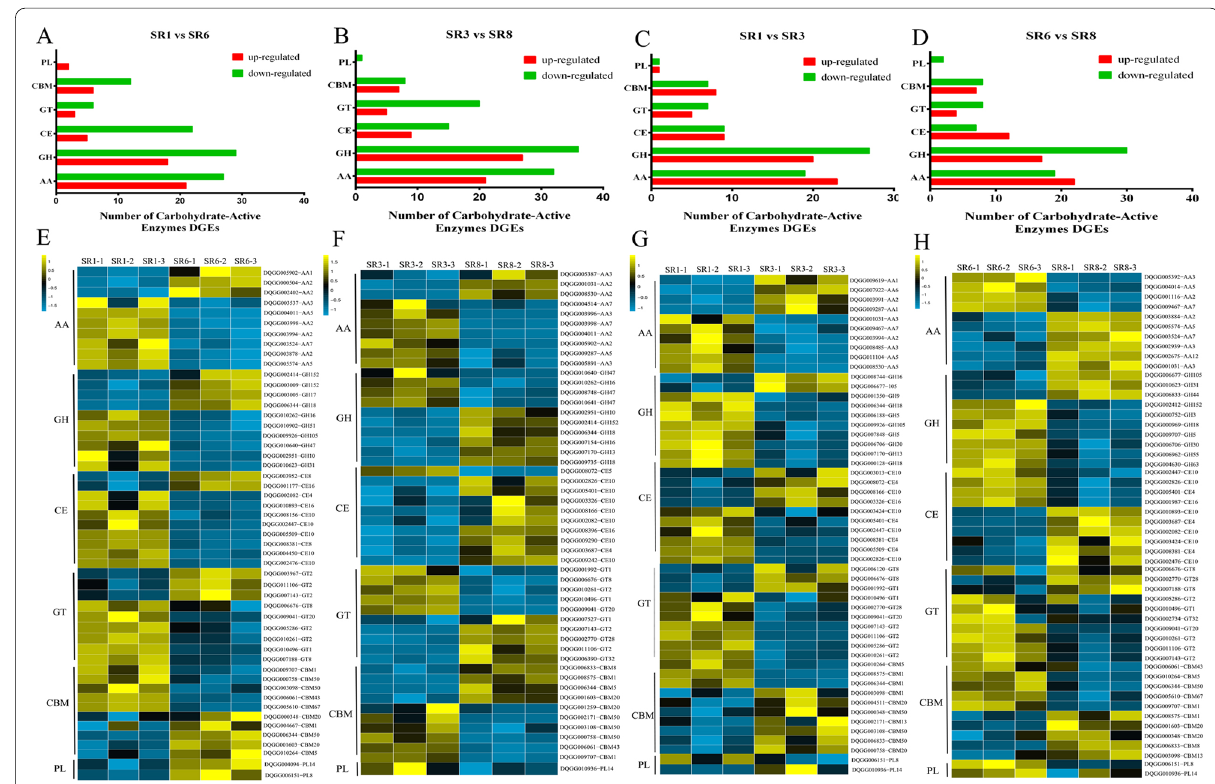
Fig. 4 Difference analysis of carbohydrate enzyme genes under the different temperature treatments. A – D Comparison of the number of differentially expressed carbohydrate enzyme genes between different treatments. E–H Expression levels of the top ten genes with significant changes in each carbohydrate enzyme (AA, GH, CE, GT, CBM and PL) family under the different